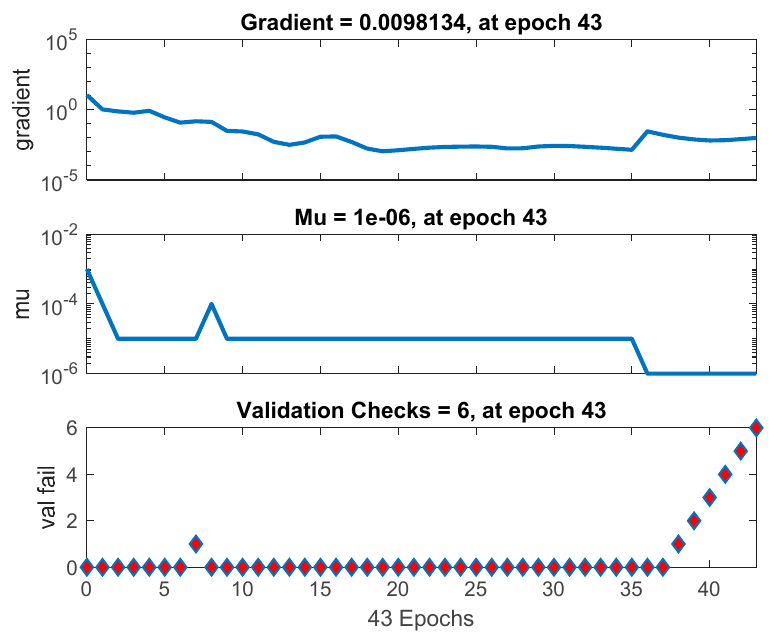
Figure 13. Plots of selected parameters in ANN training.